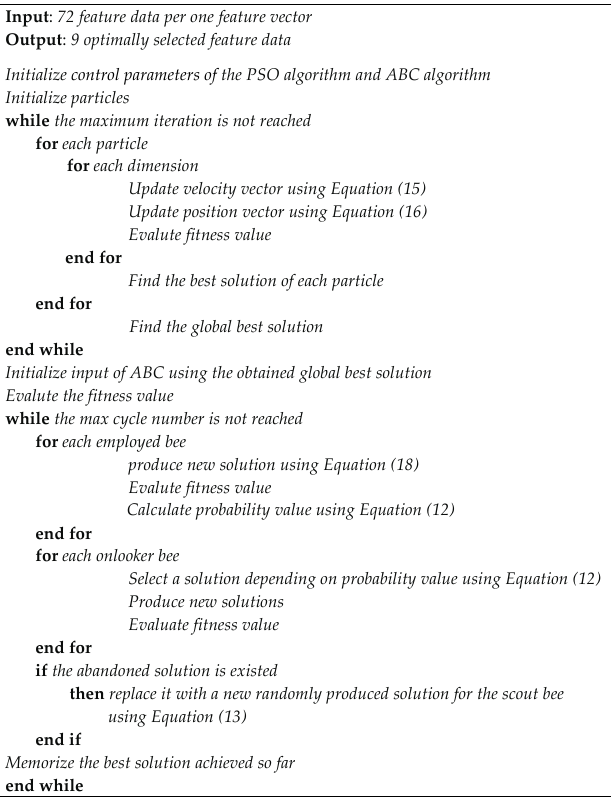
Figure 4. Pseudocode of the proposed adaptive ABC-PSO algorithm.